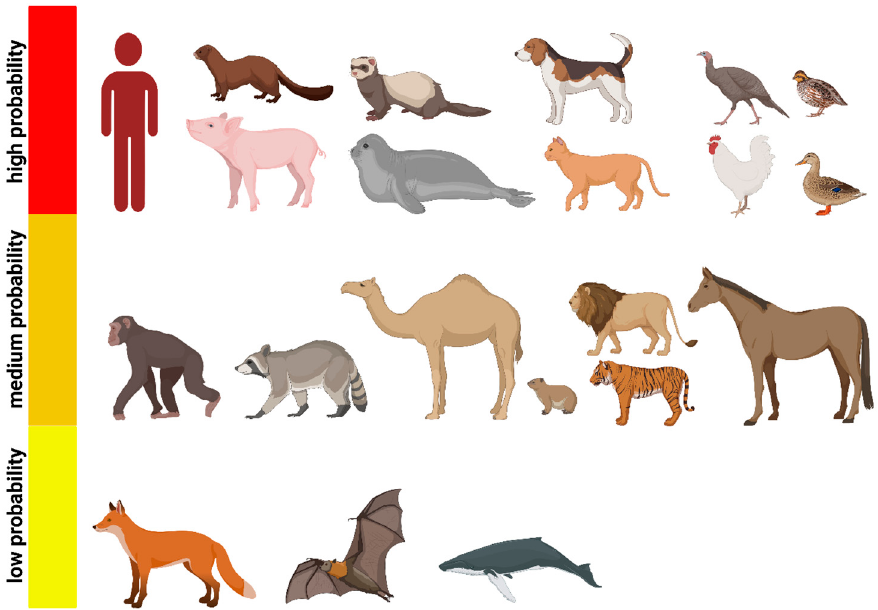
Figure 3. Potential “mixing vessel” hosts for the generation of zoonotic animal influenza viruses. Potential mixing vessel hosts according to the frequency of infection, close contact with humans, the high number of populations, and the distribution of avian- and human-type receptors. Humans, pigs, minks, ferrets, seals, dogs, cats, and birds, particularly turkeys, chickens, quails, and ducks, are the “high probability” mixing vessel hosts; “medium probability” mixing vessel hosts are non-human primates, raccoons, camels, pikas, zoo animals, including tigers and lions, and horses. The “low probability” hosts for the generation of zoonotic animal IAV are foxes, bats, and